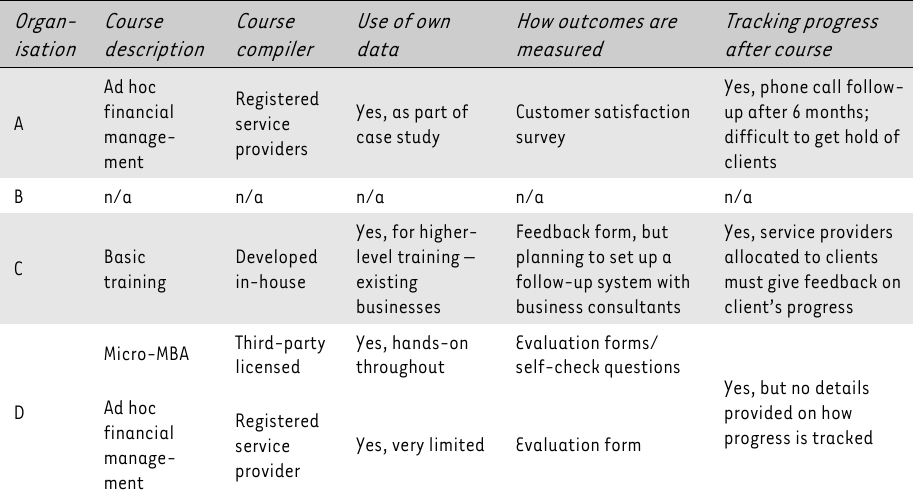
TABLE 4: Training courses offered at each organisation that include financial management training –